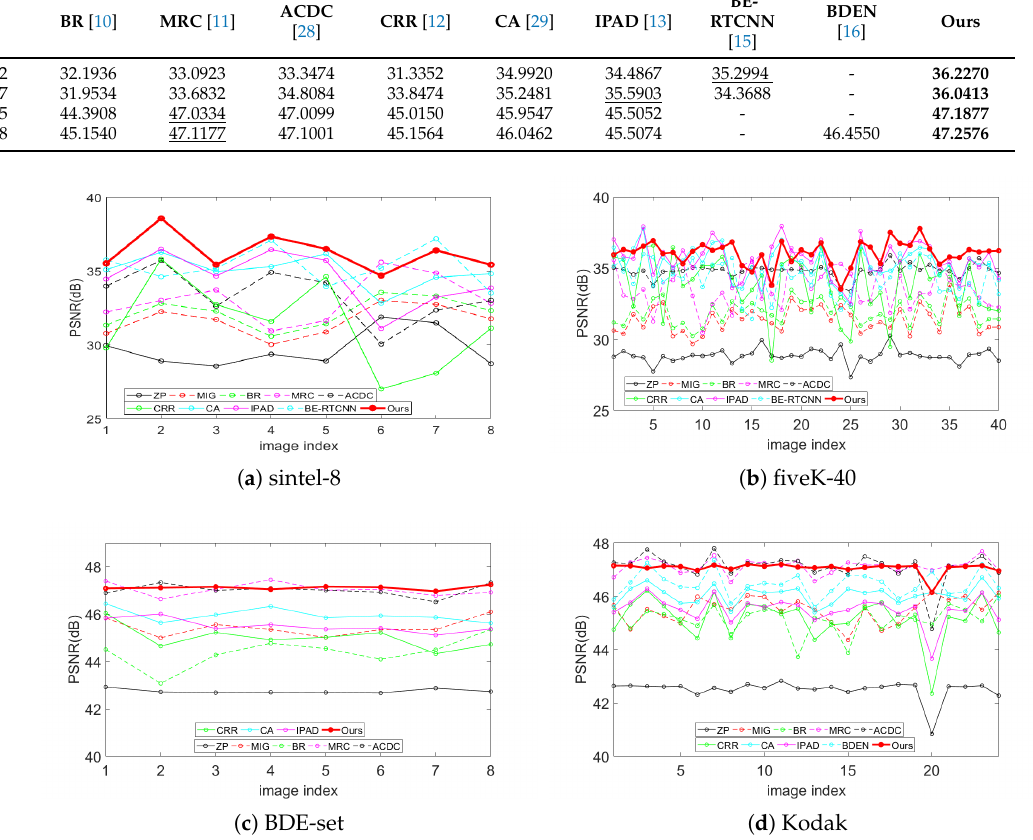
Figure 3. PSNR curve s comparison with state-of-the-art on four test